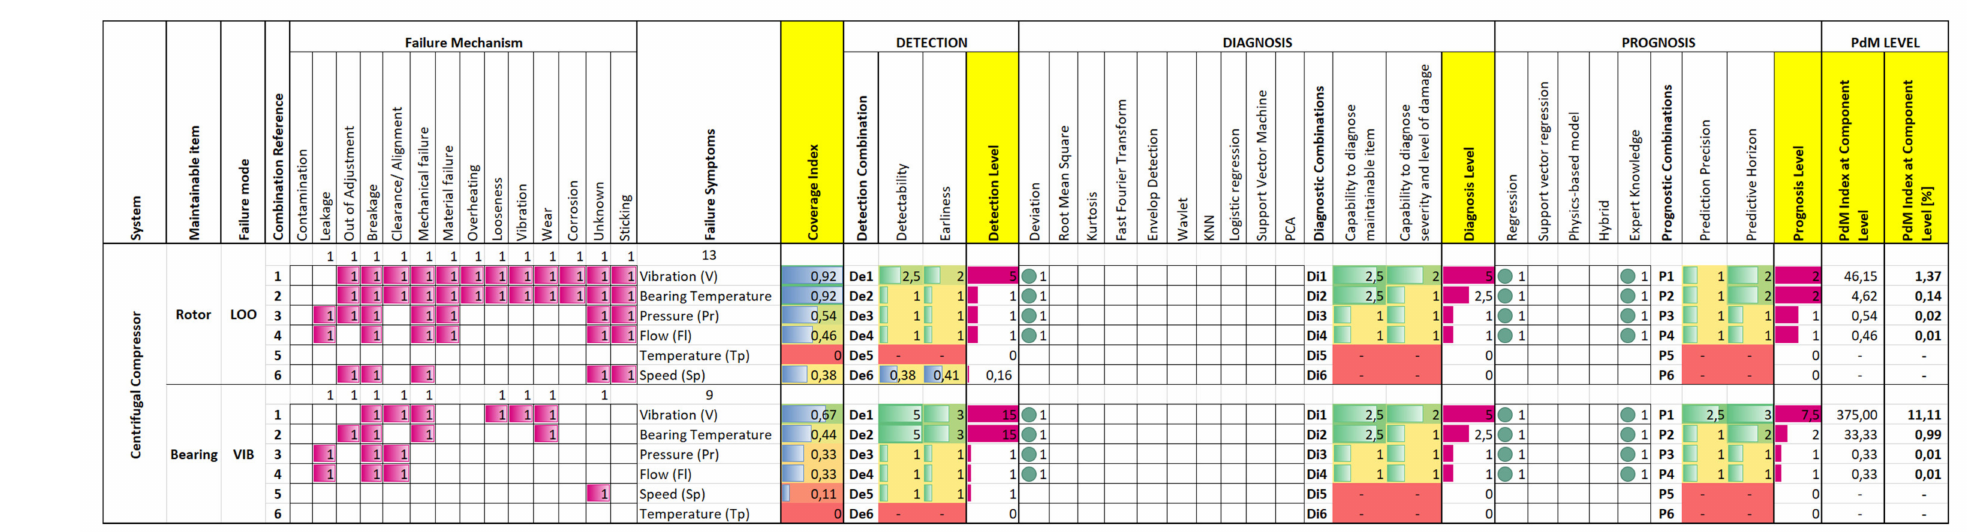
Figure 1. Snapshot of final PdM assessment matrix based on the case